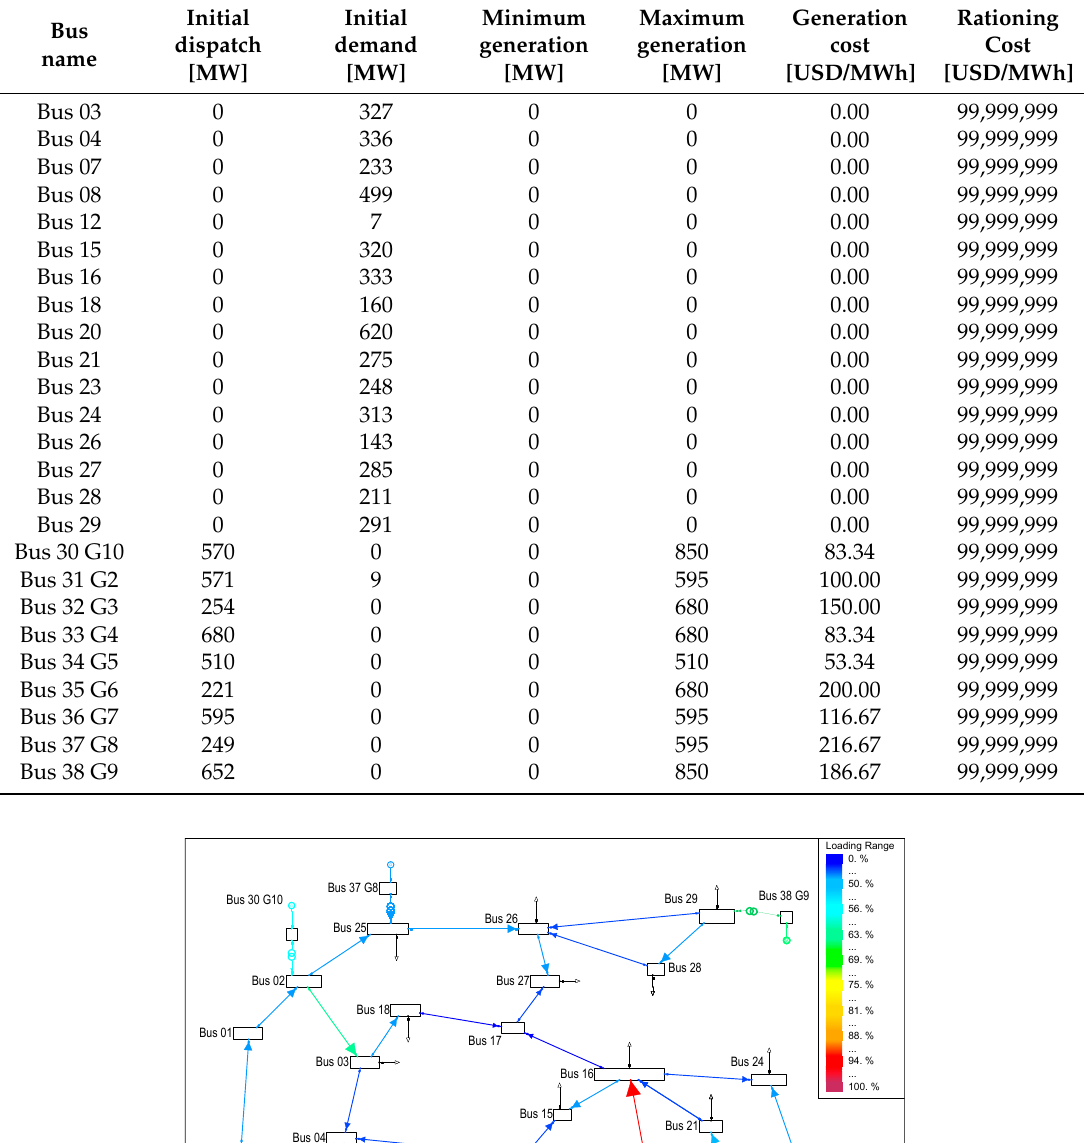
Table 1. Initial operation of the power system.